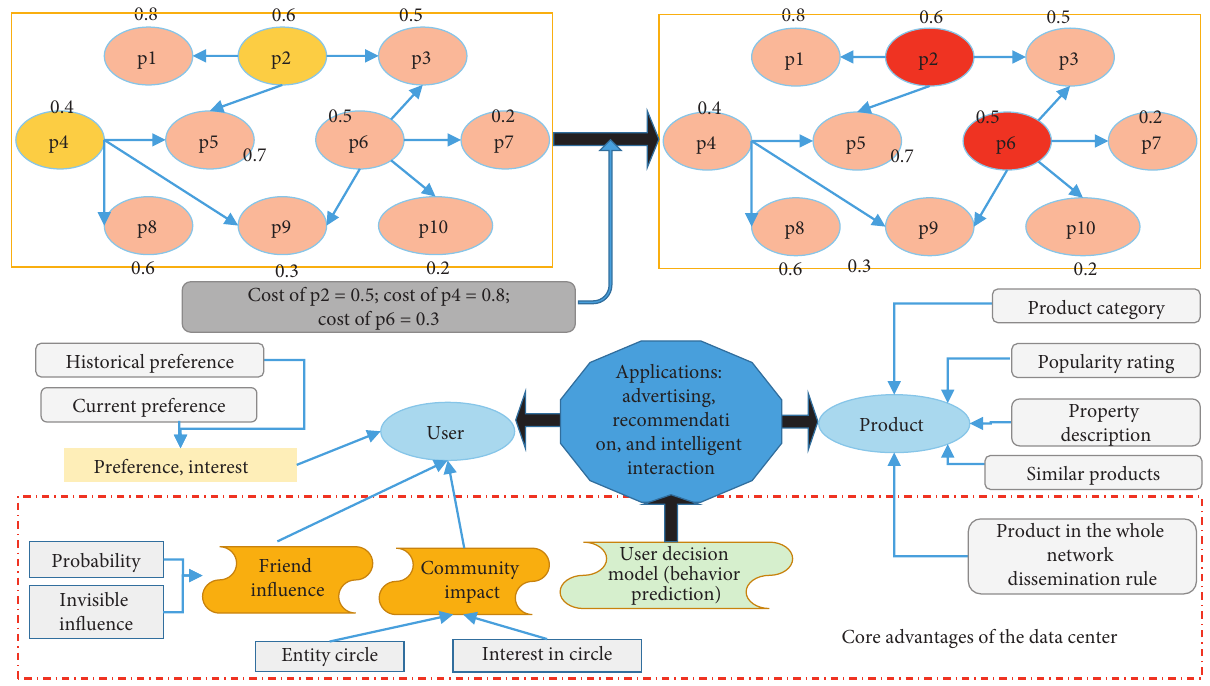
Figure 1: Examples of multiobjective